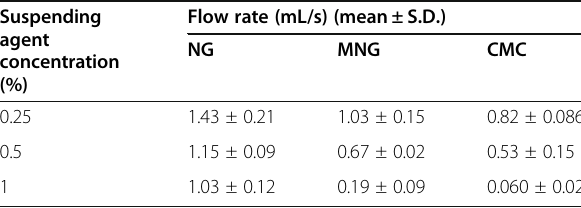
Table 5 Flow rate of the formulated